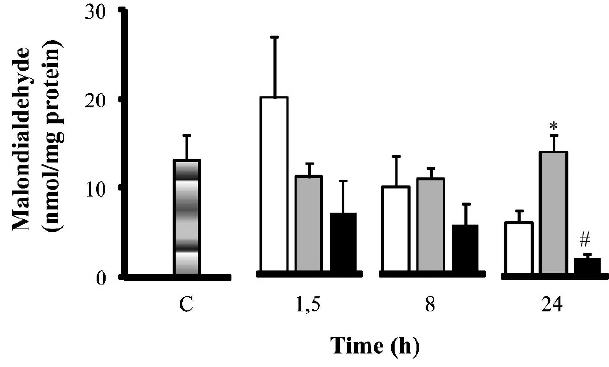
Figure 3 - Oxidative stress - MDA concentrations (nmol/mg of protein) in the intestine. Wistar male rats were challenged with LPS (LPS - white); 15 minutes later, they were treated with SH (LPS + H - black) and SS (LPS + S - gray). The levels of MDA were measured in the intestine. * p , 0.05 vs. LPS in the same period; & p , 0.05 vs. LPS and HS in the same period. n=10 mice per group. Data are means ¡ SEM.